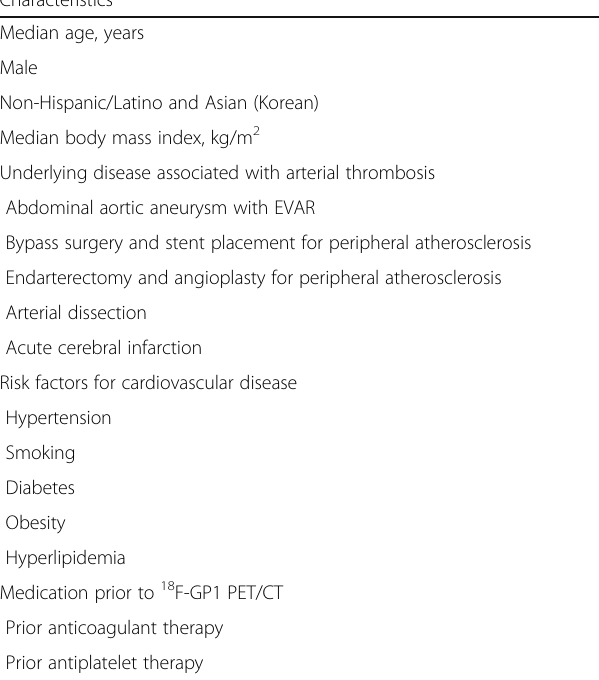
Table 1 Characteristics of the patients with acute arterial thrombosis ( n = 10)